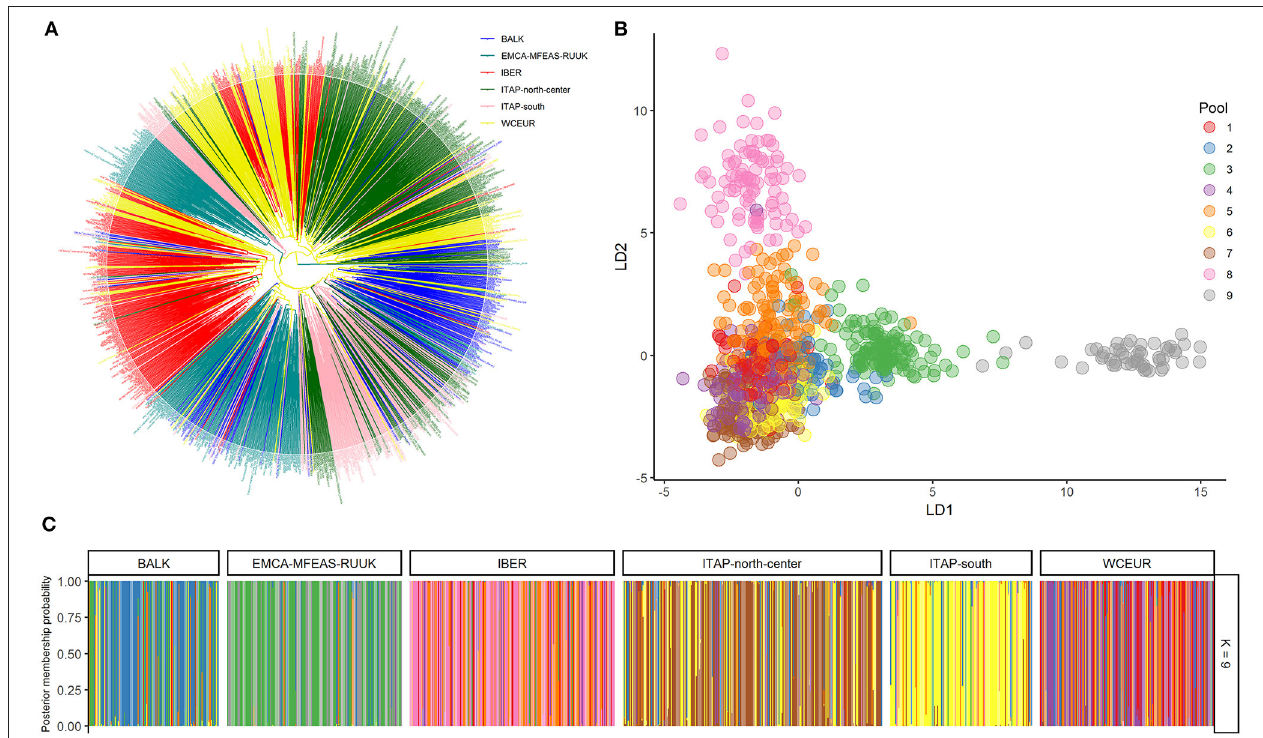
FIGURE 2 | Genetic diversity and population structure on 1,038 grapevine accessions collected across Europe, Caucasus, Middle, and Far East, genotyped by 18k SNP array. (A) UPGMA dendrogram; the varieties were highlighted based on their geographical origin ( Table 1 and Supplementary Table 1 ). (B) DAPC scatter plot based on the first and second LDs at the best K (9). (C) Bar plot of the posterior probability of group assignment for each accession analyzed. The samples are grouped by origin. UPGMA, unweighted pair group method with arithmetic mean; DAPC, discriminant analysis of principal